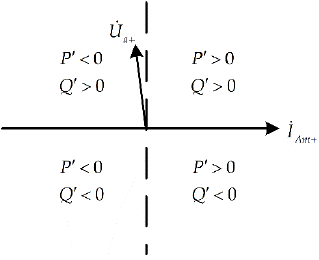
Figure 14. The relationship between the injected power from the interconnector side and the phase angle difference between U a and İ Am +